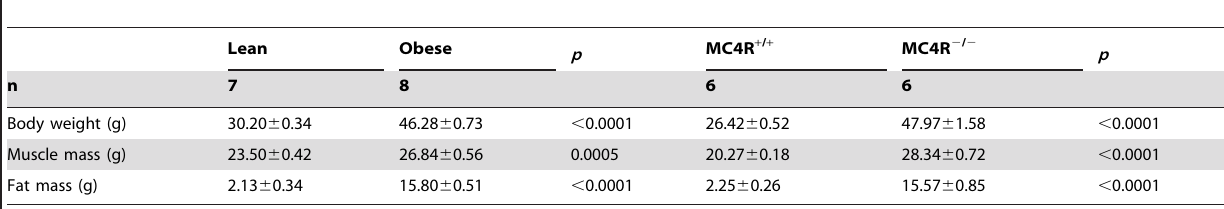
Table 1. Body composition of diet-induced obese and MC4R 2 / 2 mice utilized in radioligand binding studies compared to their respective lean